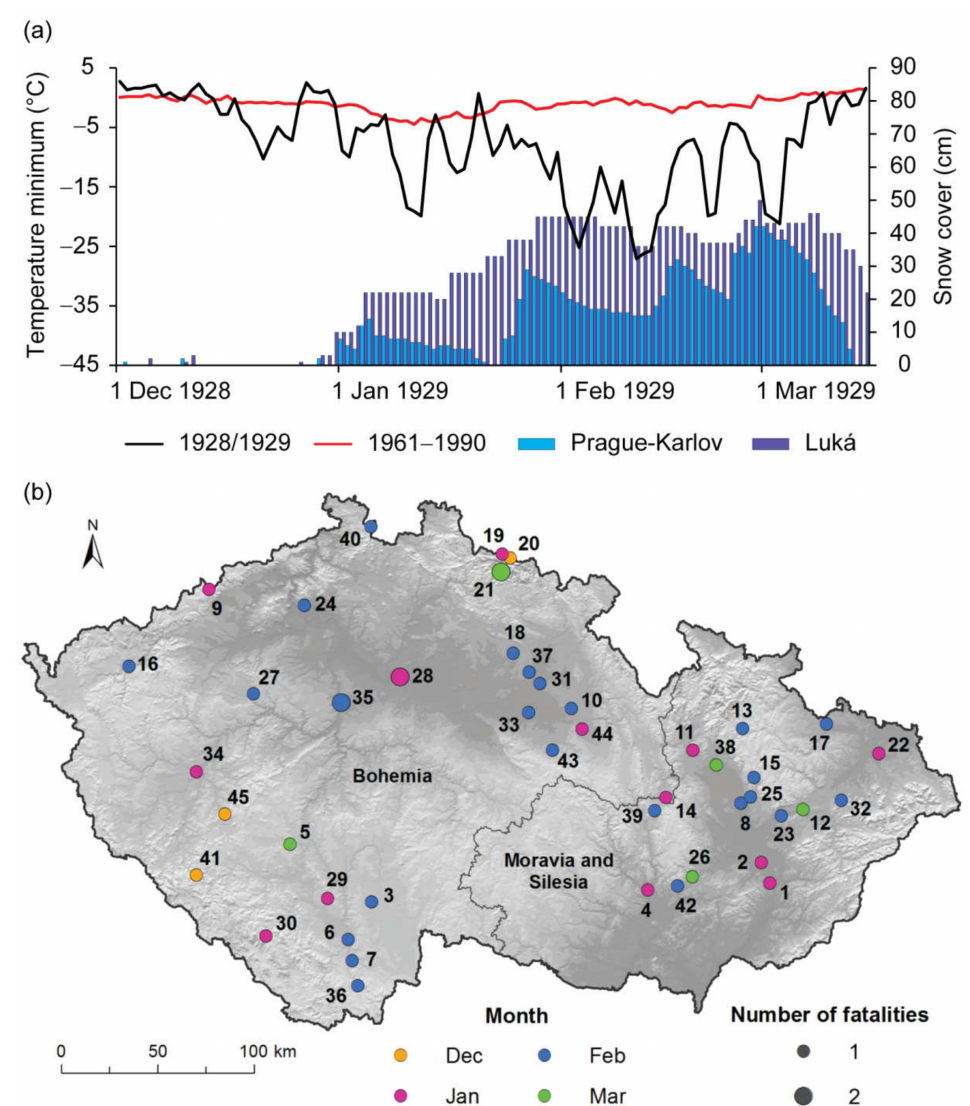
Figure 9. ( a ) Fluctuations in daily temperature minima T min at the Prague-Klementinum station (T min from 1 December to 15 March in the 1961–1990 reference period for comparison with T min in 1928 / 1929 appears in red) and daily depths of snow cover at the Prague-Karlov and Luk á stations for 1 December 1928–15 March 1929; ( b ) places with fatalities attributable to frosts or snowdrifts in the Czech Lands for individual months: 1—Bˇelov, 2—B í lany (today Kromˇeˇr í ž), 3—Bošilec,